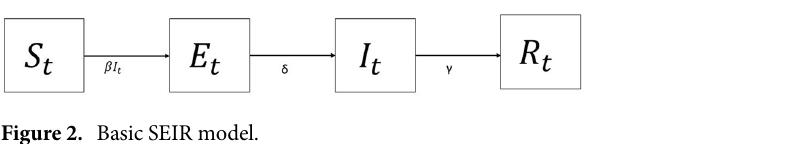
Figure 2. Basic SEIR